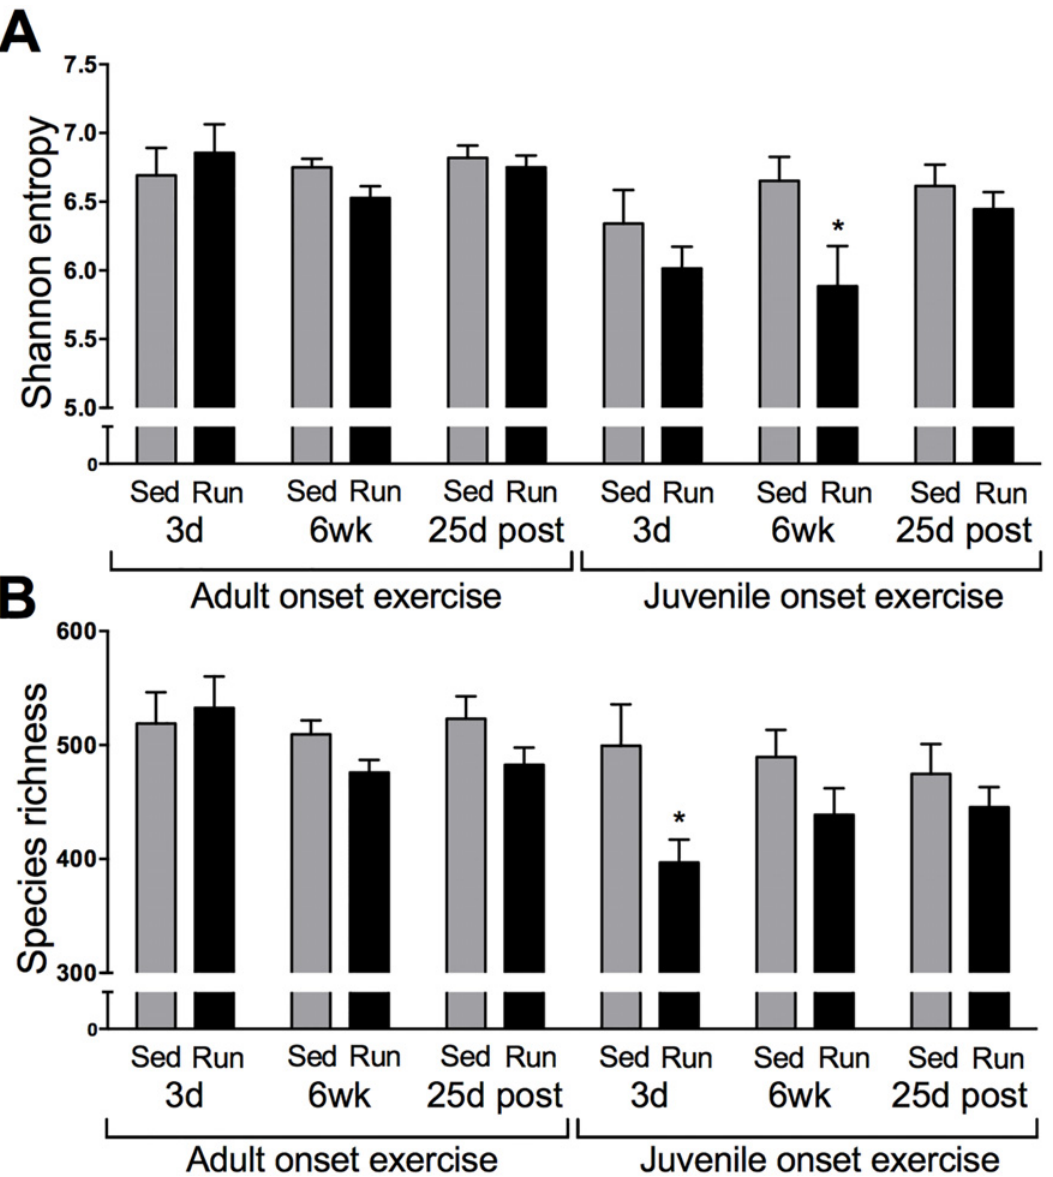
Fig 2. Early life exercise and age altered alpha diversity. Measures of alpha diversity for adult and juvenile run and sed rats after three days (3d) and six weeks (6 wk) of wheel running, and 25 days following exercise cessation (25d post). A) Shannon entropy, an indicator of an even community structure, was significantly higher in the adults than juveniles. Juvenile runners displayed decreased Shannon entropy overall and at 6 wk. B) Species richness was significantly higher in the adults relative to juveniles. Runners had significantly fewer species overall than their sedentary counterparts, and juvenile runners had significantly fewer species than juvenile sedentary rats 3d following the start of exercise. Data are represented as mean ± SEM; * p <